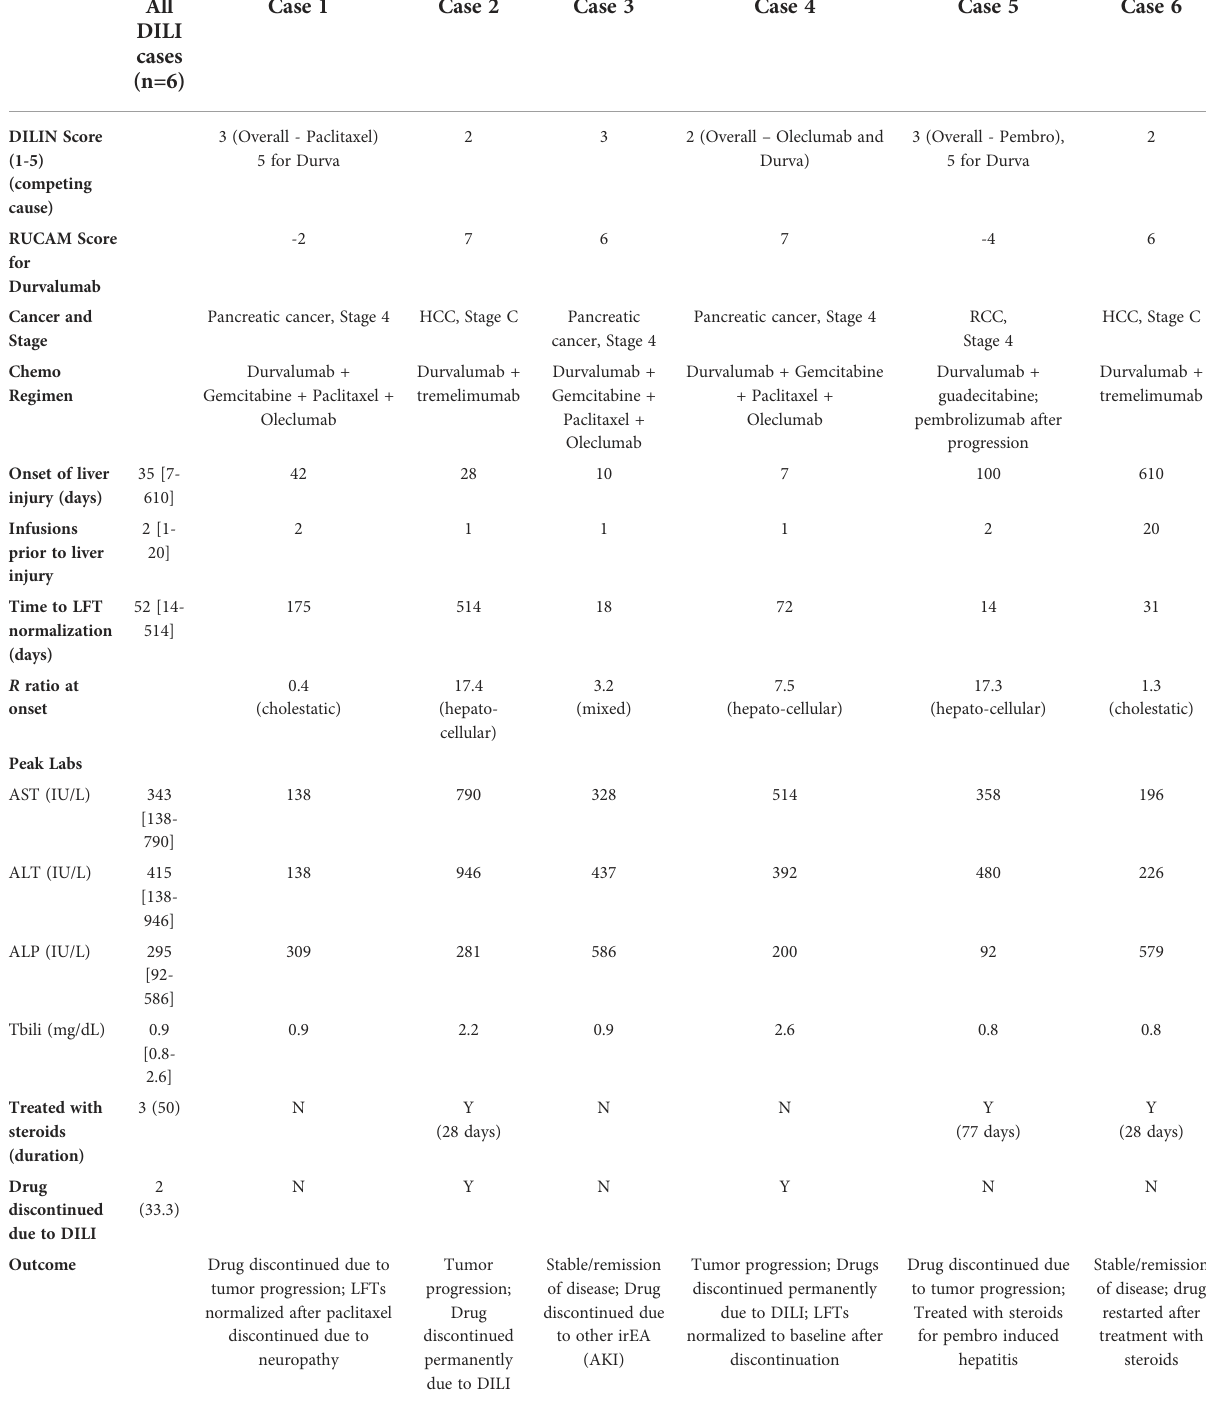
TABLE 3 Clinical characteristics of six patients who developed DILI due to any drug on